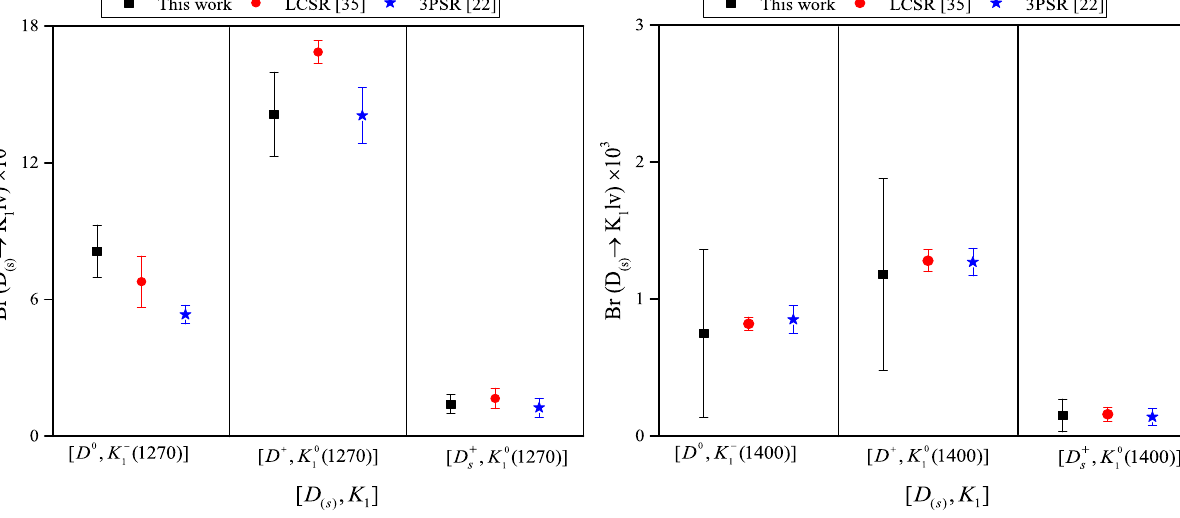
Fig. 8 Theatrical values for the branching ratio of the semileptonic D ( s ) → K 1 with K 1 = K 1 ( 1270 ), K 1 ( 1400 ) at θ K = − ( 34 ± 13 )